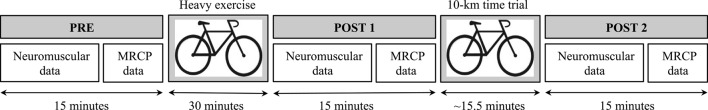
Experimental session design and timeline. PRE, pre-exercise condition; POST1, post-heavy exercise condition; POST2, post-time trial condition; MRCP, movement-related cortical potential.